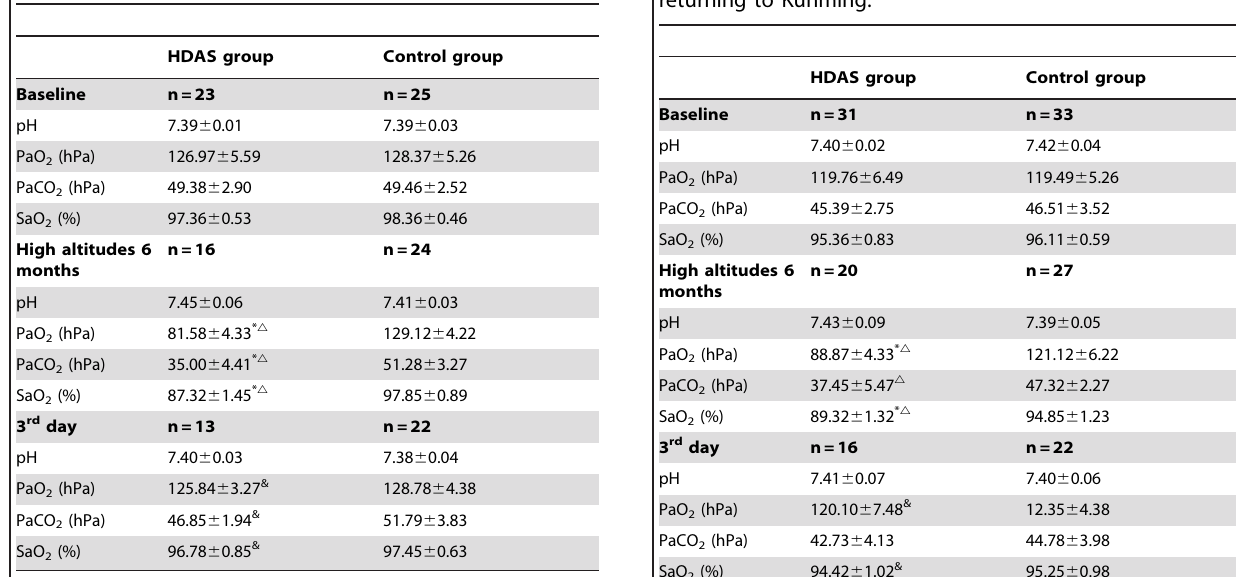
Table 4. pH, PaO2, PaCO2, and SaO2 of subjects after returning to Chongqing. Table 5. pH, PaO2, PaCO2, and SaO2 of subjects after